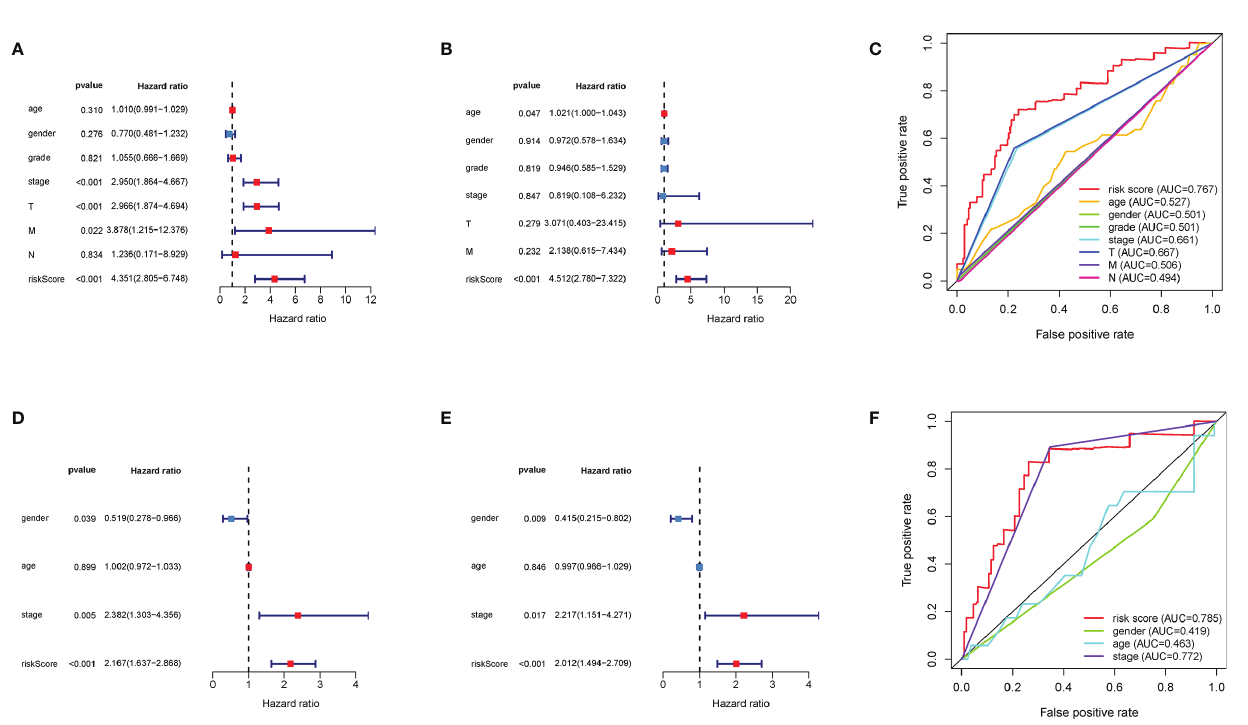
FIGURE 9 | Comparison of prediction accuracy among the classi fi ers and other factors. The (A) univariate Cox analysis and (B) multivariate Cox analysis of DEMG- based risk score and other factors in TCGA. (C) The DEMG-based risk score was more accurate with an AUC of 0.767 in TCGA. The (D) univariate Cox analysis and (E) multivariate Cox analysis of risk score and other factors in LIRI_JP. (F) The DEMG-based risk score was more accurate with an AUC of 0.785 in LIRI_JP. DEMGs, differentially expressed metabolic genes; AUC, area under the